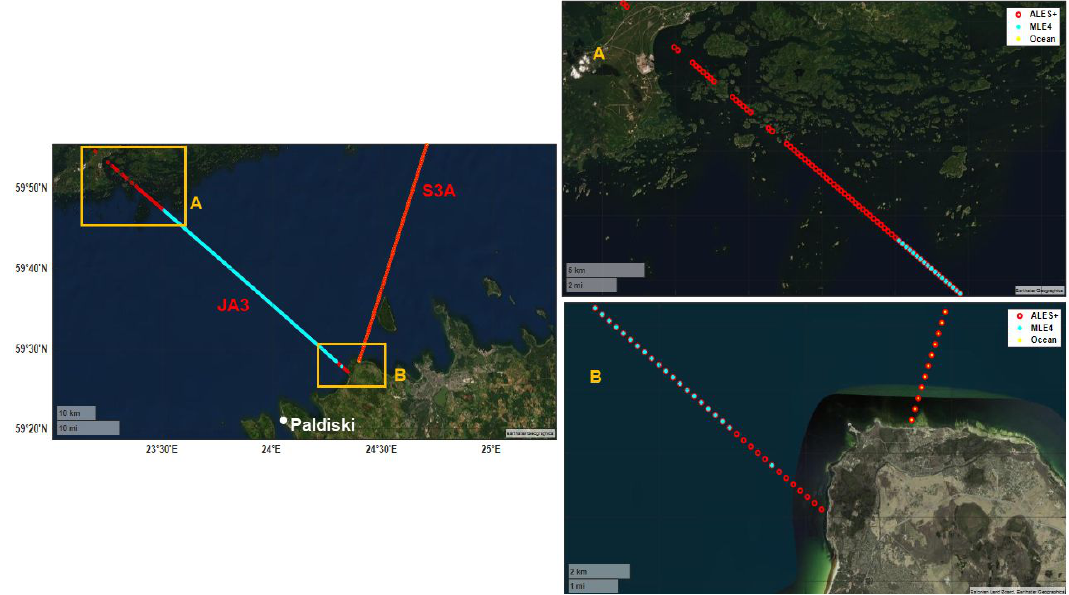
Figure 4: Locations of the near-coast SA tracks: the S3A (pass#186 cycle 13) and JA3 (pass#016 cycle 34) tracks performance near the shoreline at Paldiski station (left hand side). The JA3 track (A) performance using ALES+ (red) and MLE4 (blue) retrackers, zoom in near the Finnish coast; and the JA3 and S3A tracks (B) performance using ALES+ and ALES+SAR (red), Ocean (yellow) and MLE4 (blue) retrackers near the Estonian coast (right hand side). The coastline source is the Google